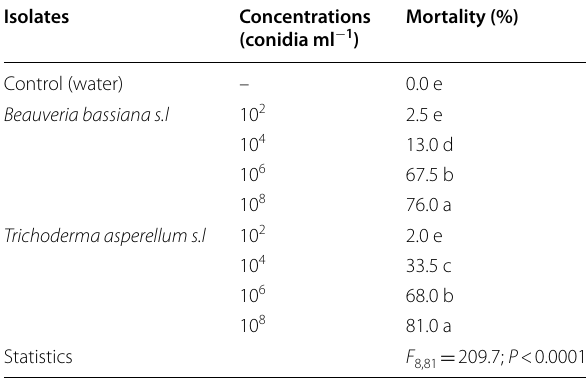
Means followed by the same letters within each column are not significantly different at P < 0.05 according to DMRT